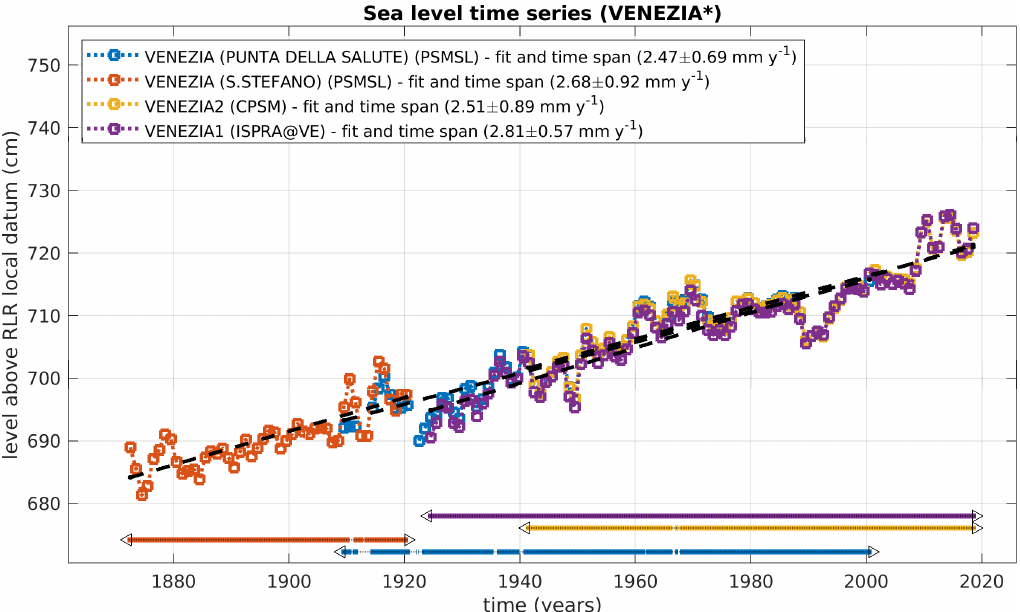
Figure 3. Four relative sea level tide gauge time series available in Venice are plotted. Colors show yearly means formed from monthly means processed with 25-month moving average. VENEZIA, VENEZIA1, and VENEZIA2 in overlapping periods are almost coincident as they come from the same historical time series of VENEZIA PUNTA DELLA SALUTE (1923–2020). Dashed black lines show best fit for each of four time series in Venice. Horizontal lines in the same color as sea level plots indicate their respective data availability and temporal